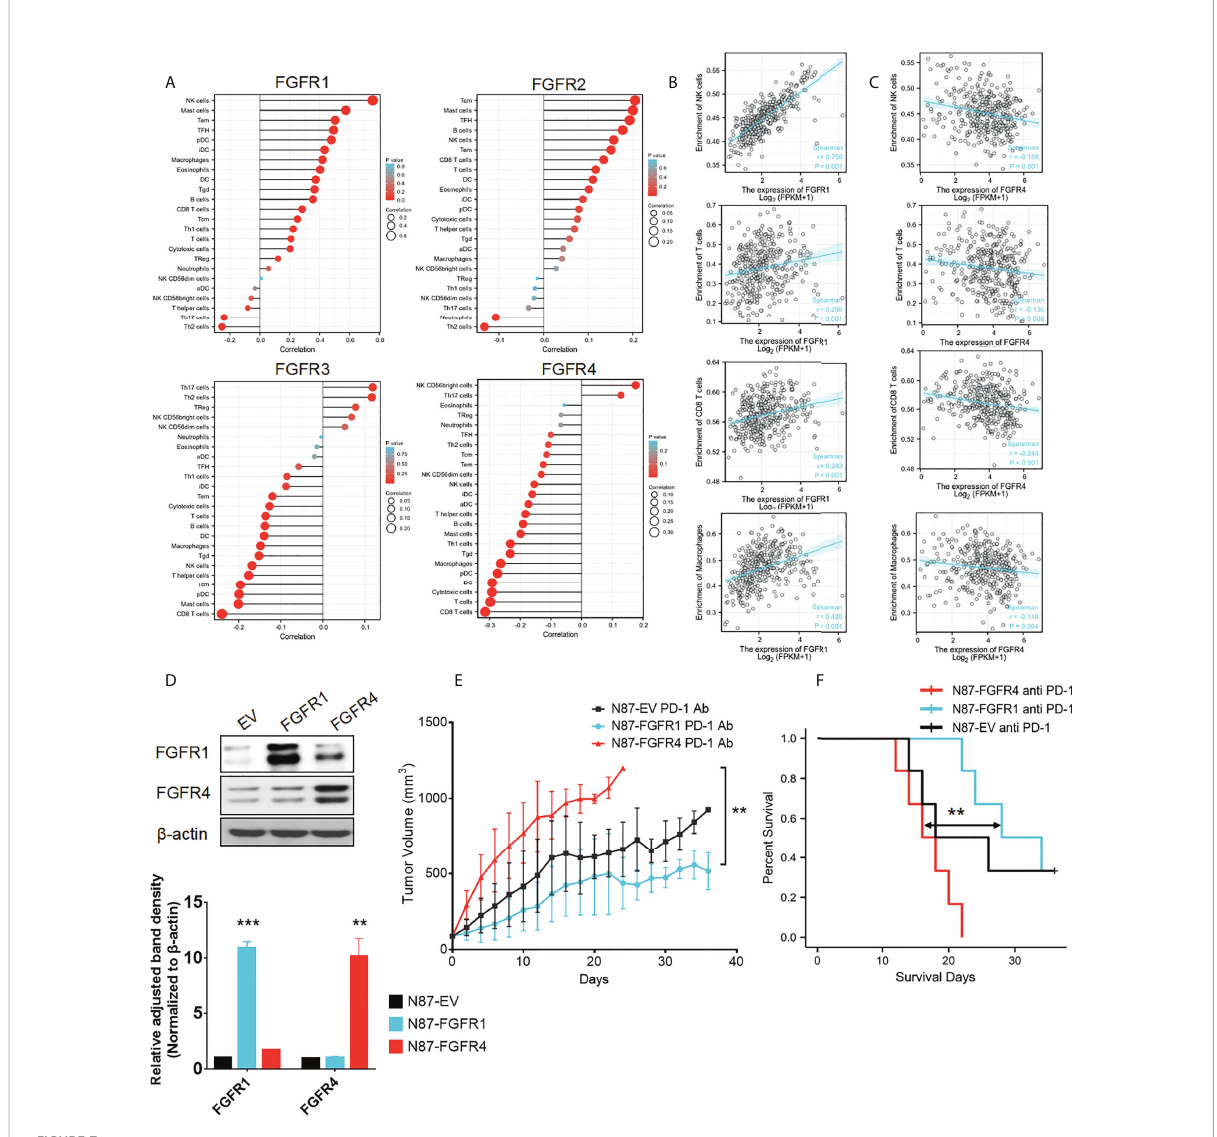
FIGURE 7 Expression of FGFRs related to tumor immune cell in fi ltration in TCGA-STAD. (A) The correlation between FGFRs and the different immune in fi ltrating cells in TCGA-STAD. (A, B) The correlation between FGFR1 (B) /FGFR4 (C) and NK cell/CD8+ T-cells/B-cells/macrophages in cell in fi ltration in TCGA-STAD. (D) FGFR1 and FGFR4 were stable and overexpressed in NCI-N87 cells. (E) The anti-PD-1 mAb was more effective in controlling tumor volume in mice with FGFR1 than FGFR4 overexpressed NCI-N87 xenografts. (F) Kaplan – Meier plots of mouse survival. Survival days represents as the time from Day 1 to the day of death or euthanization. ** p <0.01, *** p <0.001, log-rank test between